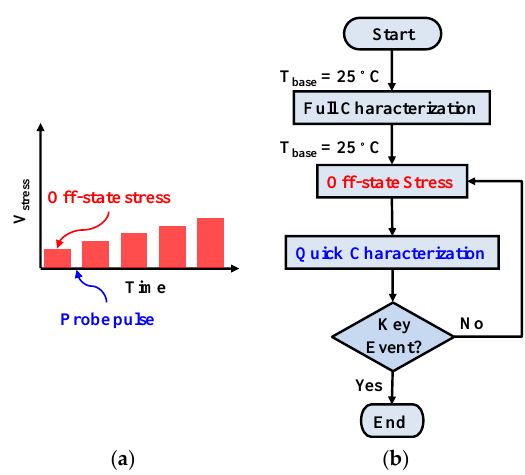
Figure 1. ( a ) Control voltages for step-stress experiments performed in this study. The device is stressed for a length of time: step-stress on gate and source (30 s) and step-stress on drain (3 min); bias is repeatedly switched to the ON-state for short intervals to evaluate the change in DC figures of merit induced by the OFF-state bias; ( b ) flow chart of a typical experiment. The device is stressed and regularly characterized in the process. The measurement loop is executed before reaching the critical voltage (key event), wherein irreversible damage to the device occurs. Table 1. Device electrical parameters monitored during characterization.